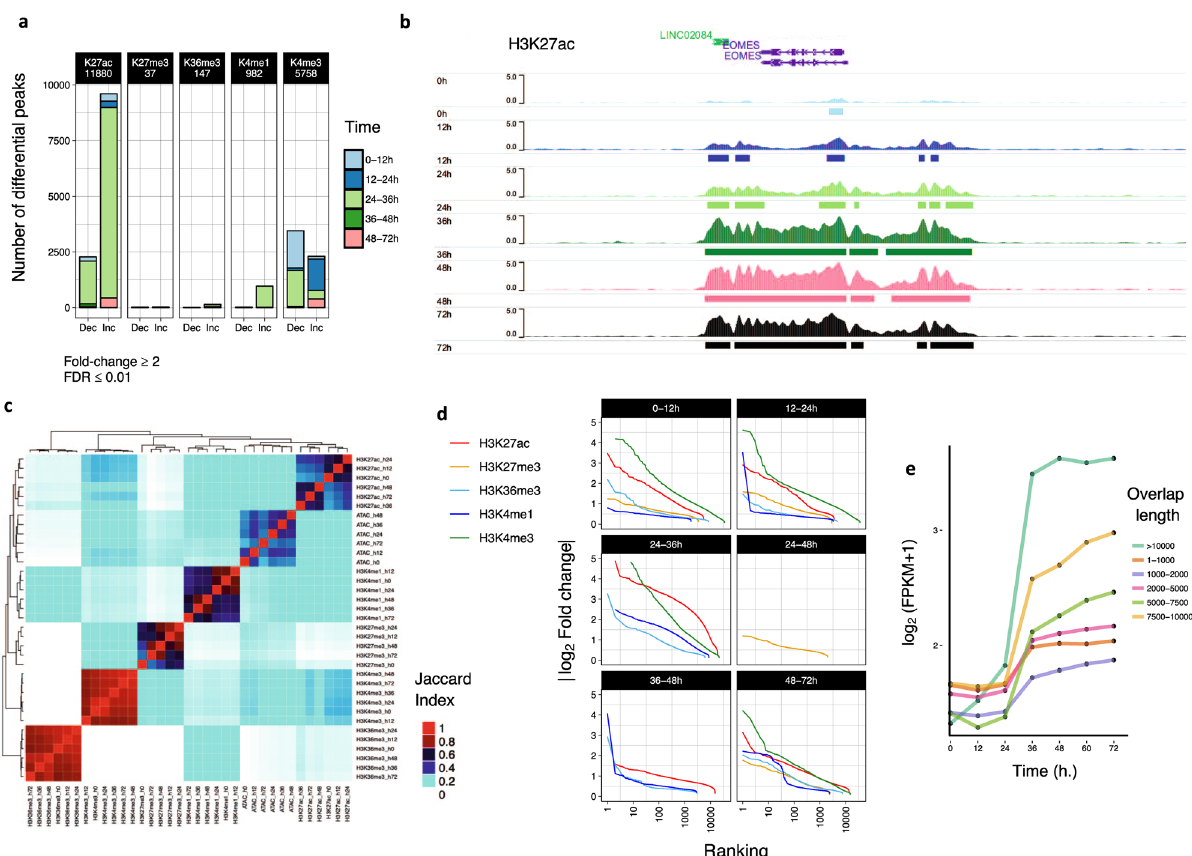
Fig. 5 | Histone modi fi cation dynamics during differentiation of EG1 synchronised hPSCs. a The number of genomic regions containing dynamic chromatin marks in consecutive time points based on histone mark ChIP-seq. b H3K27ac ChIP-seq for EOMES locus (GENCODE v29; fi rst replicate shown). c Hierarchical clustering of Jaccard Index values obtained for overlaps between